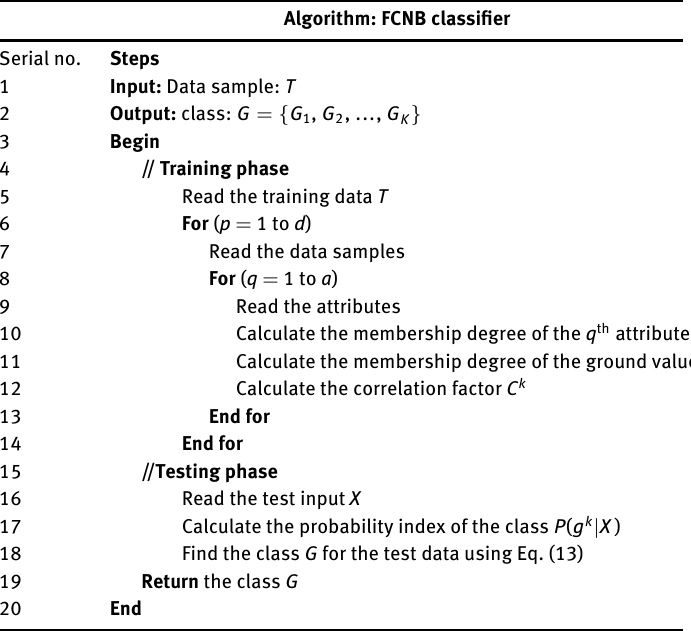
Algorithm 1: Pseudo Code of the Proposed FCNB